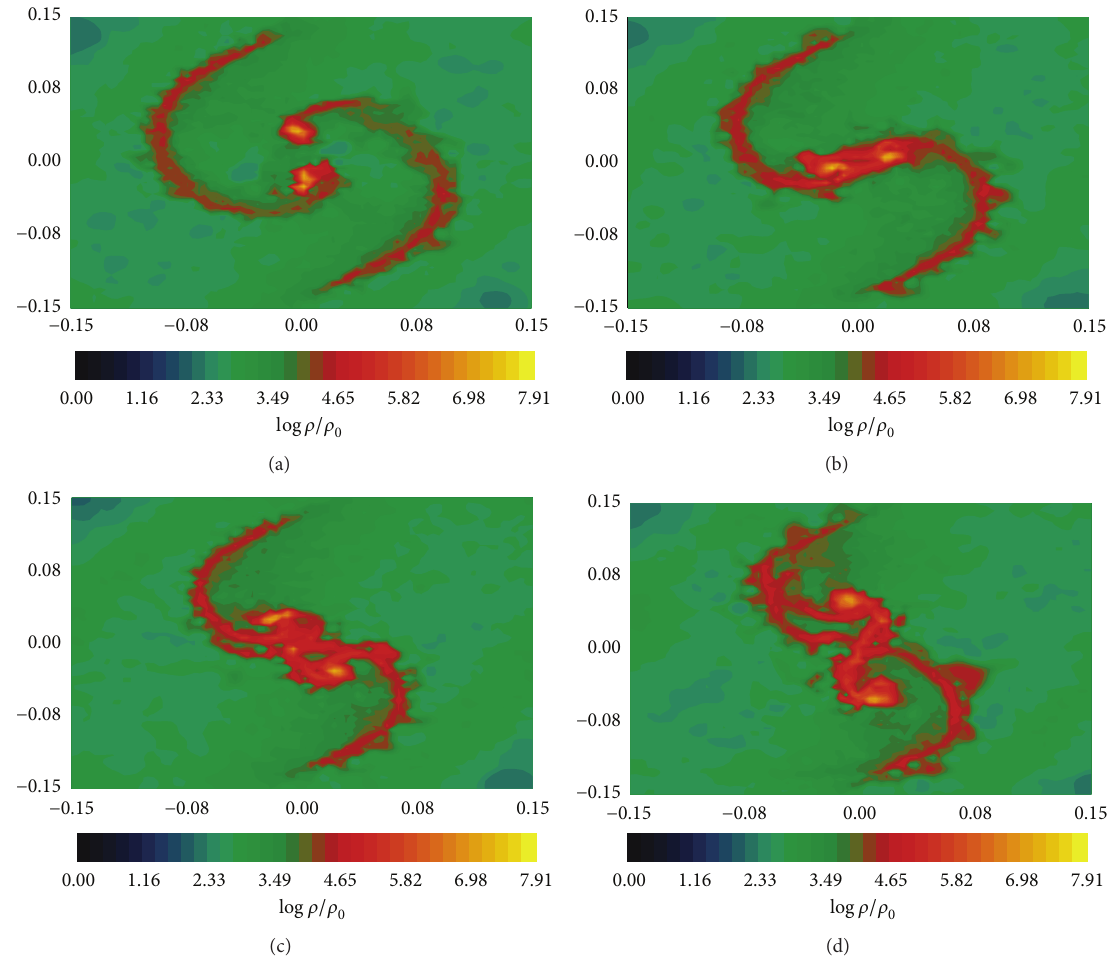
= max = 100 × Ω 𝜌 = 𝑤 𝑐 ) at max